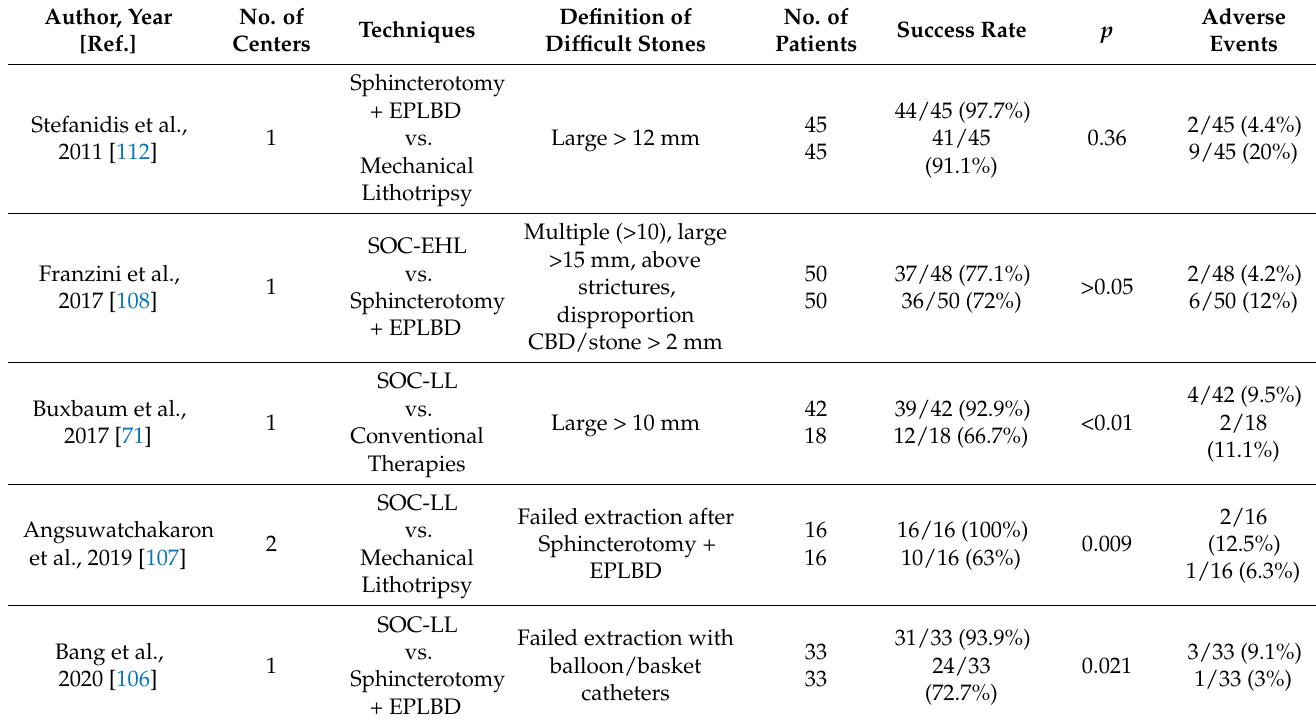
Table 2. Randomized controlled trials comparing different lithotripsy techniques. EPLBD, endo- scopic papillary large balloon dilation; SOC, single-operator cholangioscopy; EHL, electrohydraulic lithotripsy; LL, laser lithotripsy; CBD, common bile